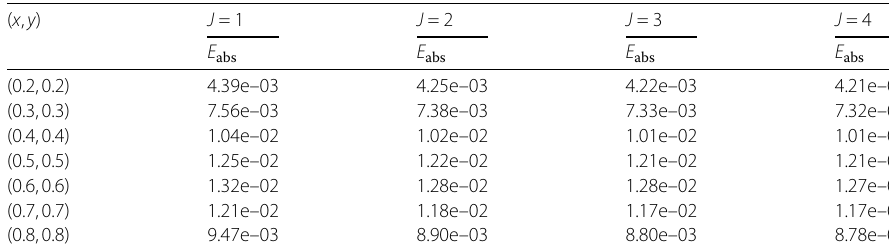
Table 5 Absolute errors at different points of Example 5.2 at t = 0.2, γ = 0.9 ( x , y )